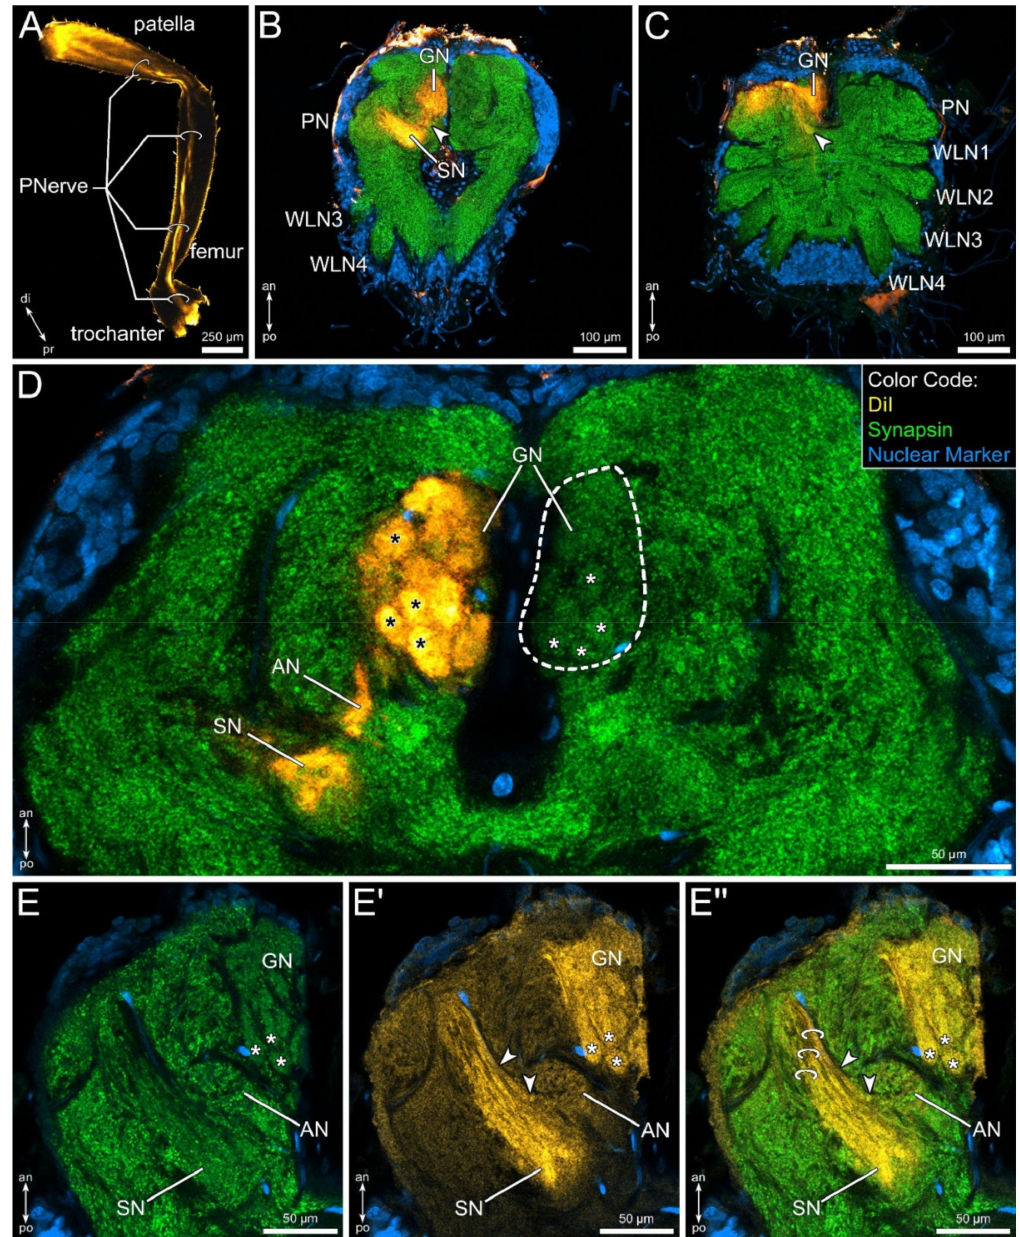
Figure 5. Innervation of the pedipalpal neuropil revealed by lipophilic dye labeling (DiI, yellow), injected at the distal part of the patella, combined with fluorescent labeling of the synaptic regions (green) and cell bodies (blue). ( A ) Overview of a dye injected pedipalp, visualizing the projection pattern of the pedipalpal nerve (PNerve). ( B , C ) Maximum projections of two consecutive horizontal sections, from ventral ( B ) to dorsal ( C ). Dye-labelled fibers enter the glomerular (GN) and the stratified neuropil (SN). Further, a small neuropil between GN and SN is labelled (arrowheads; accessory neuropil: AN). ( D ) Detail of the pedipalpal neuropil (PN), horizontal view. The glomeruli (asterisks) are clearly labelled. Furthermore, the accessory neuropil (AN) and the medial portion of the stratified neuropil (SN) are marked. Note that no labeling is evident in the contralateral GN (dashed line). ( E , E’ , E” ) Horizontal section of the pedipalpal neuropil labelled against synapsin ( E ) and by lipophilic dye ( E’ ); both channels merged in ( E” ). Glomeruli are indicated by asterisks. Note the layered innervation of the stratified neuropil, indicated by rings in ( E” ). The AN seems to receive input from anterior fibers associated with the SN (arrowheads in ( E’ , E” )). Other abbreviations: an: anterior; di: distal; po: posterior; pr: proximal; WLN1–4: walking leg neuromeres